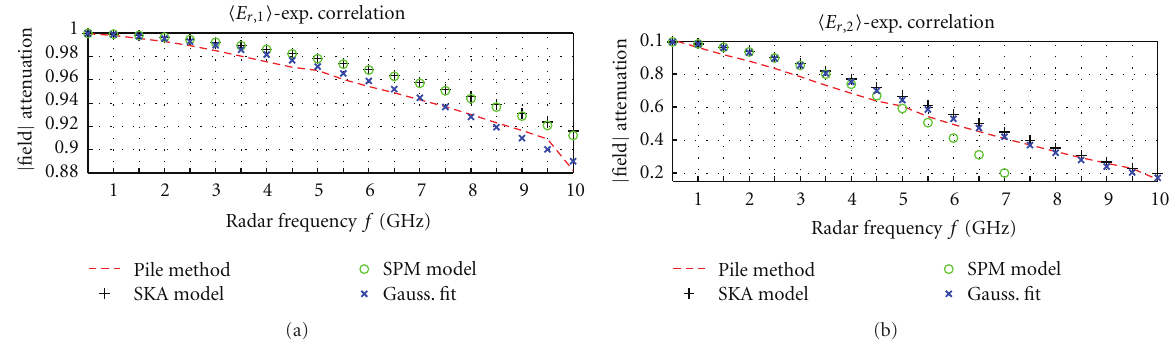
Figure 7: The same simulation parameters as in Figure 6 (with L c A = 4 . 0mm and L c B = 8 . 0 mm), but for exponential correlation